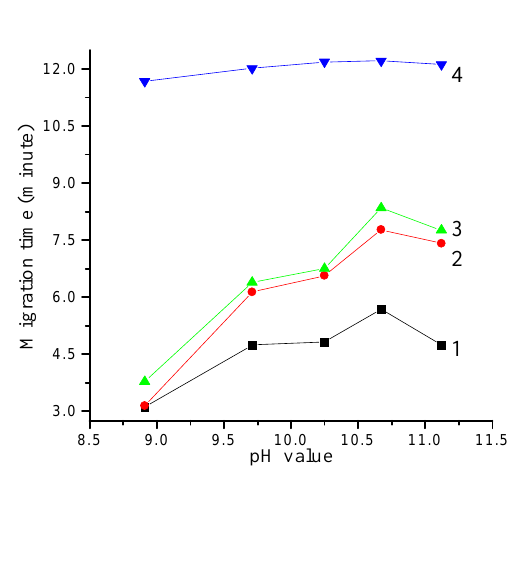
Figure 2. Effect of pH value on migration